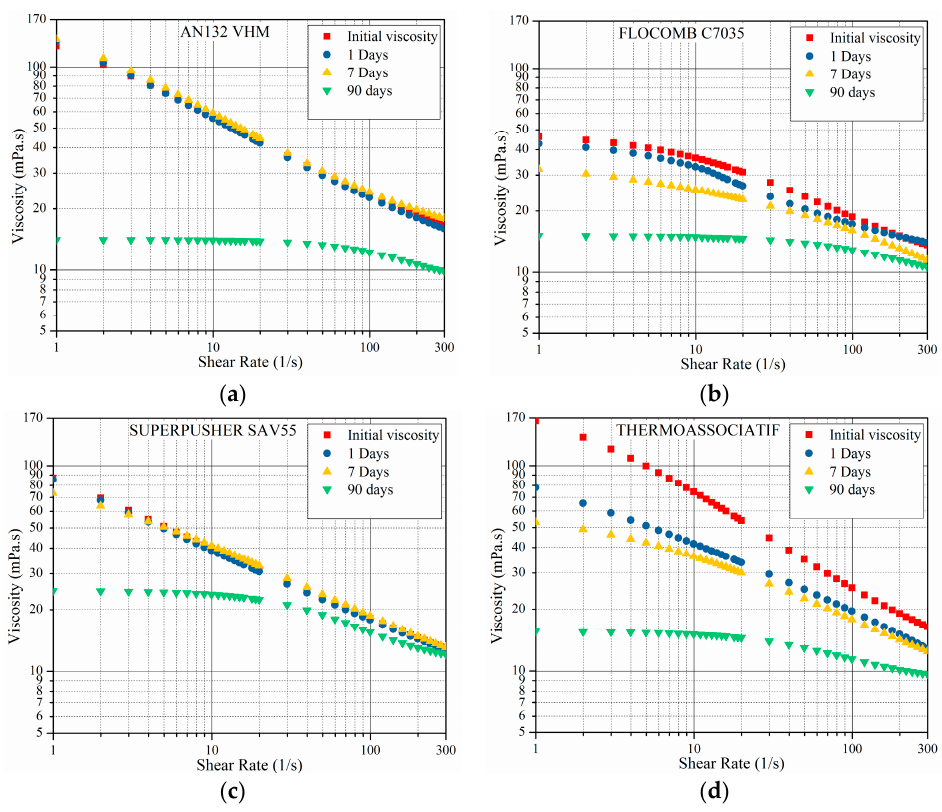
Figure 5. The viscosity as a function of shear rate measured at 25° C for polymers in 5 wt % NaCl (without IBA). Samples varied in aging time, ranging from 0 to 90 days at 80 °C.